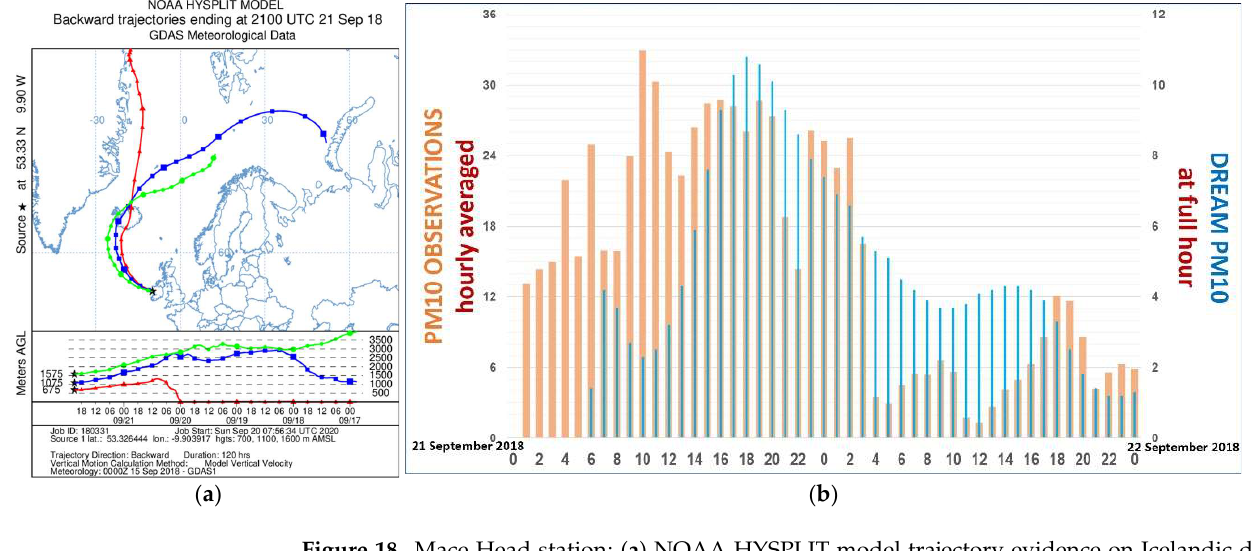
Figure 18. Mace Head station; ( a ) NOAA HYSPLIT model—trajectory evidence on Icelandic dust arriving at Mace Head at 21 UTC 21 September 2018; and ( b ) observed PM 10 (orange) and model surface concentration (blue) (µgm −3 ) over the period 21–22 September 2018. The red, blue and green lines represent simulated trajectories from the HYSPLIT model. Each line represent air parcels released from 3 different heights above ground level. Parcels are transported by the mean 3-D wind field, provided by the atmospheric model.